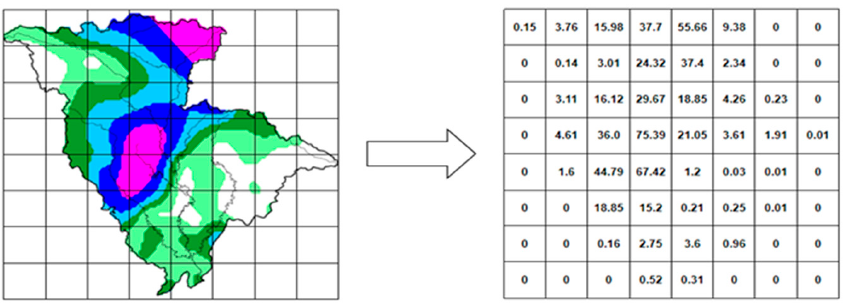
Figure 3. The precipitation distribution matrix.